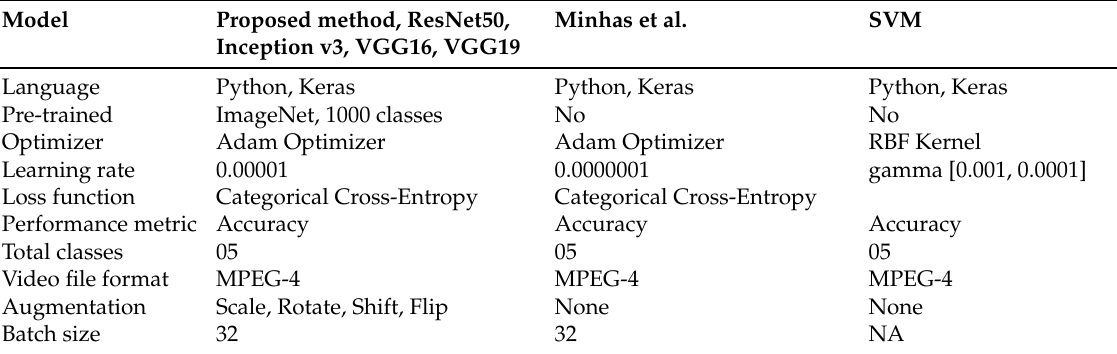
Table 3. Simulation